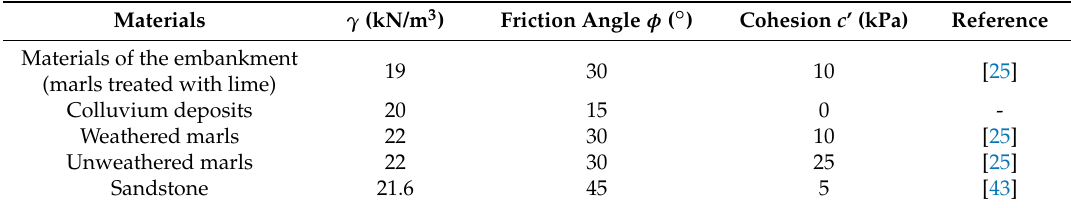
Table 2. Geotechnical parameters used as a starting point in the